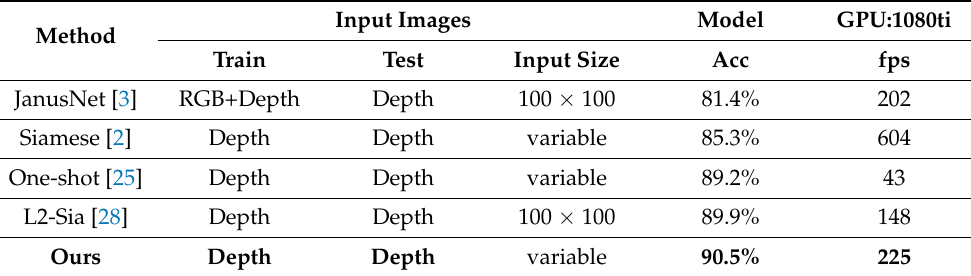
Table 5. Comparison of results achieved by different methods on the Pandora dataset.